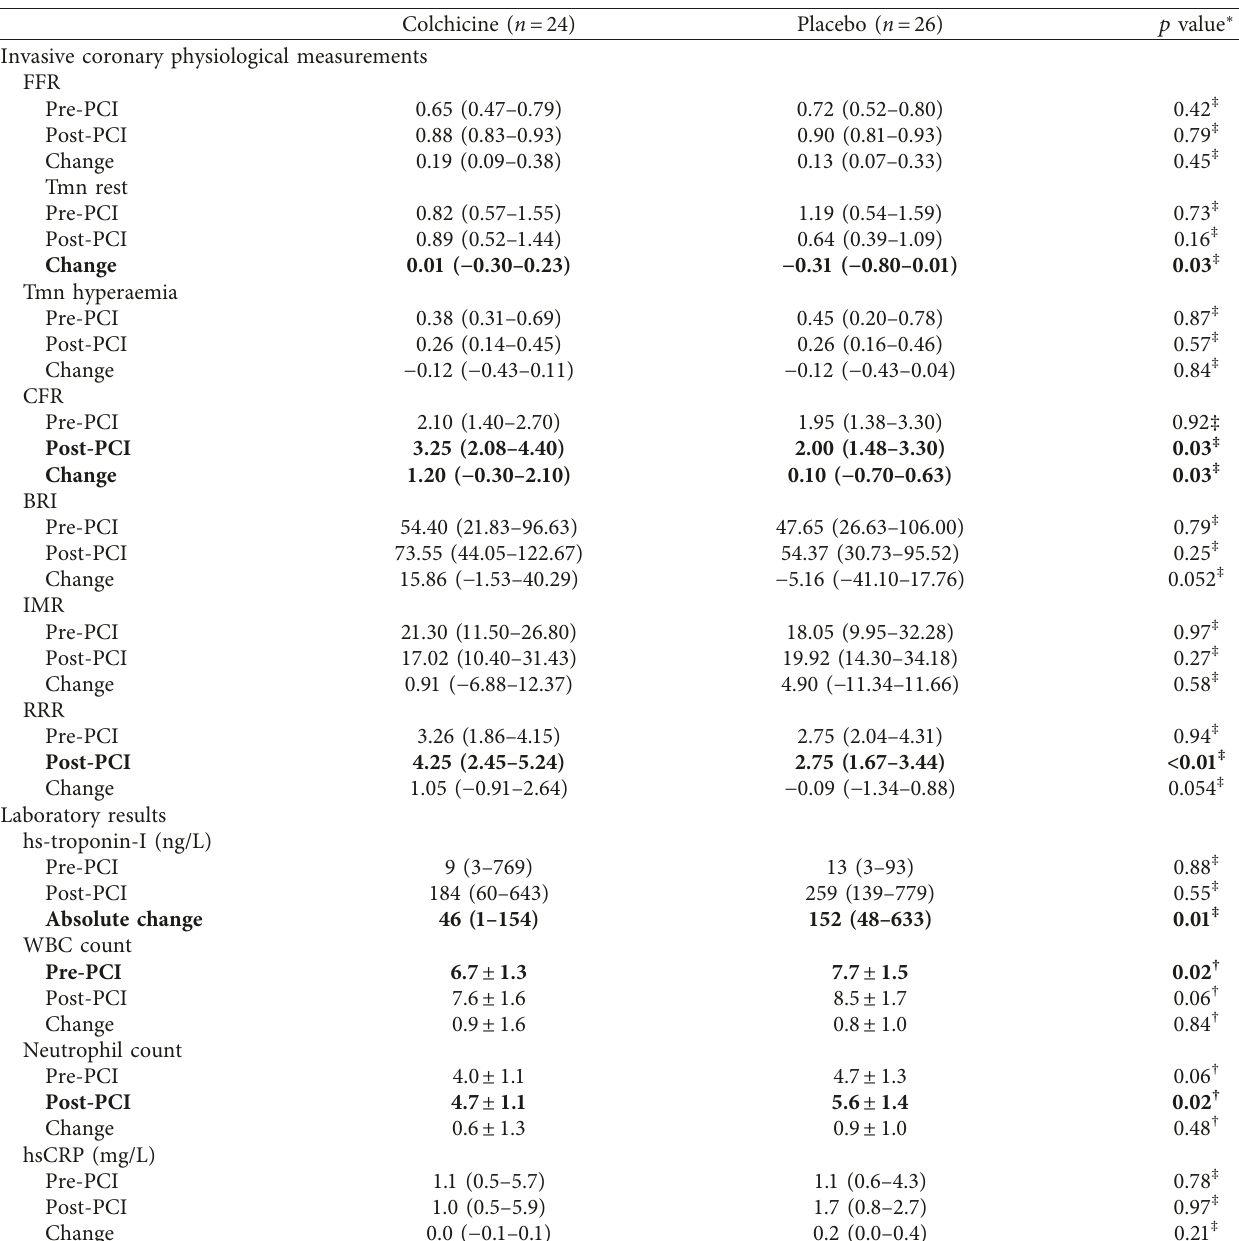
Table 3: Combined pre-PCI, post-PCI, and change in invasive coronary physiological and laboratory measurements, by study drug randomization.